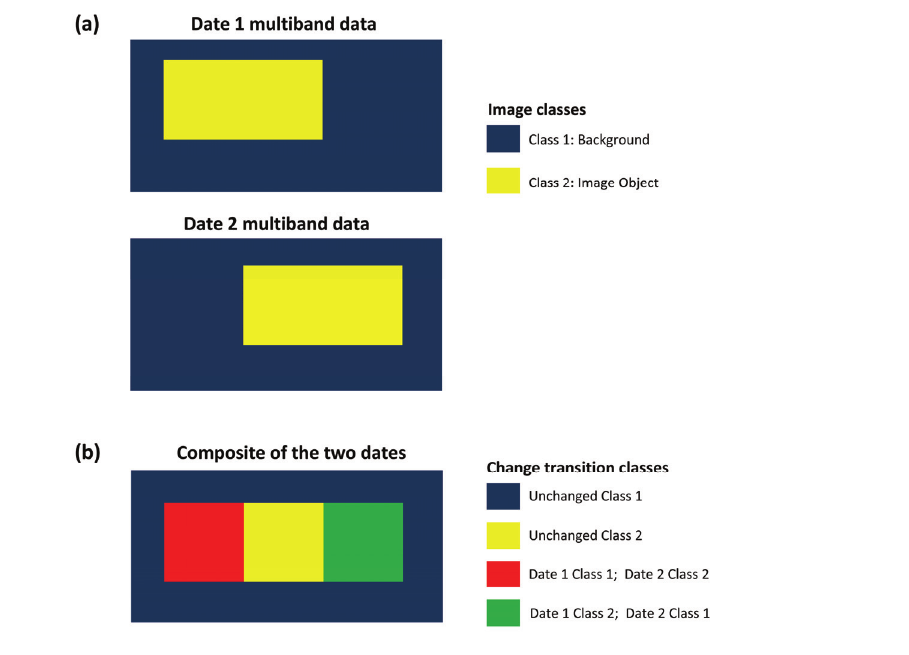
Figure 1. Schematic illustration of simulated data for a two class situation. (a) The original data consists of multiband data sets. (b) When the images are combined, a multitemporal change image is produced.